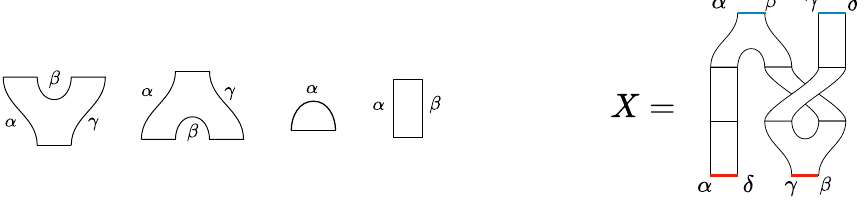
Figure 9 . On the left are the elementary cobordisms describing the modular evolution of intervals labelled by boundary conditions on the endpoints. The cutting and regluing operator X of (2.4) can be expressed by composing the elementary cobordisms as shown on the